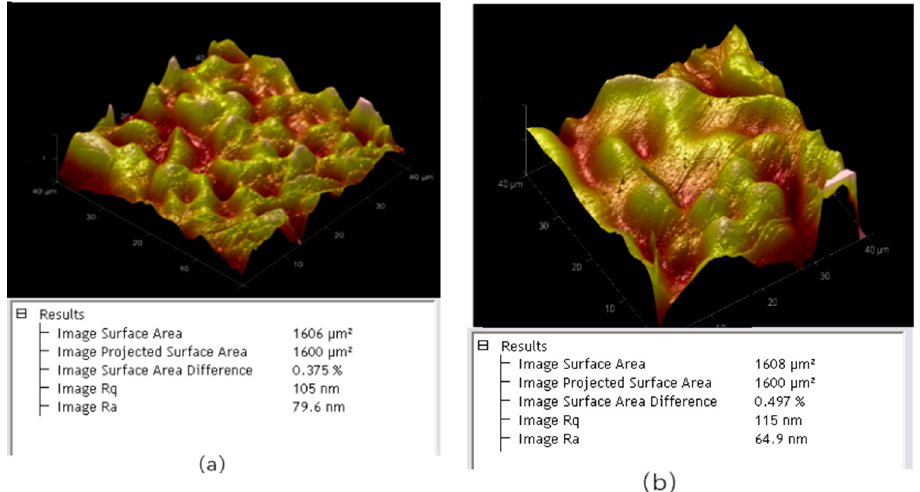
Figure 12. Testing sidewall roughness of the channel at two different spots with atomic force microscopy. ( a ) The sidewall roughness is 79.6 nm at one spot (Ra = 79.6 nm). ( b ) The sidewall roughness is 64.9 nm at another spot (Ra = 64.9 nm).